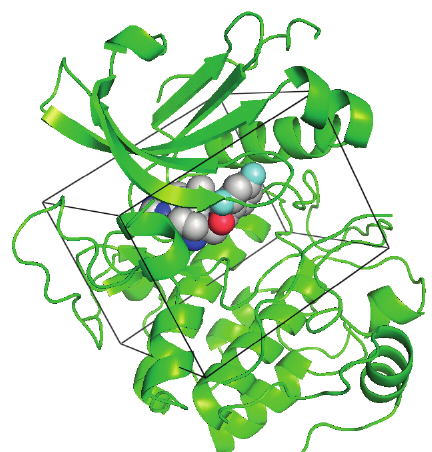
Figure 2. Crystal structure of the human Akt kinase domain in complex with a pyrrolopyrimidine inhibitor in the ATP-binding site (PDB Code 3MVH). A docking box